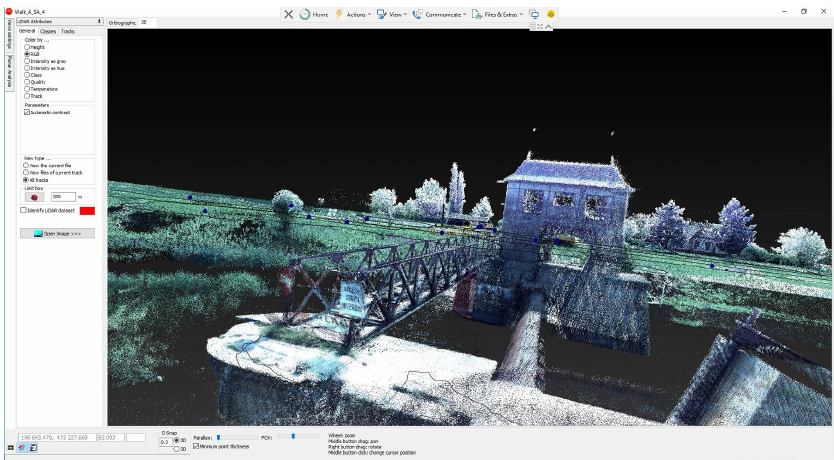
View time-adjusted point clouds on GCP. Water 2020 , 12 , x FOR PEER REVIEW